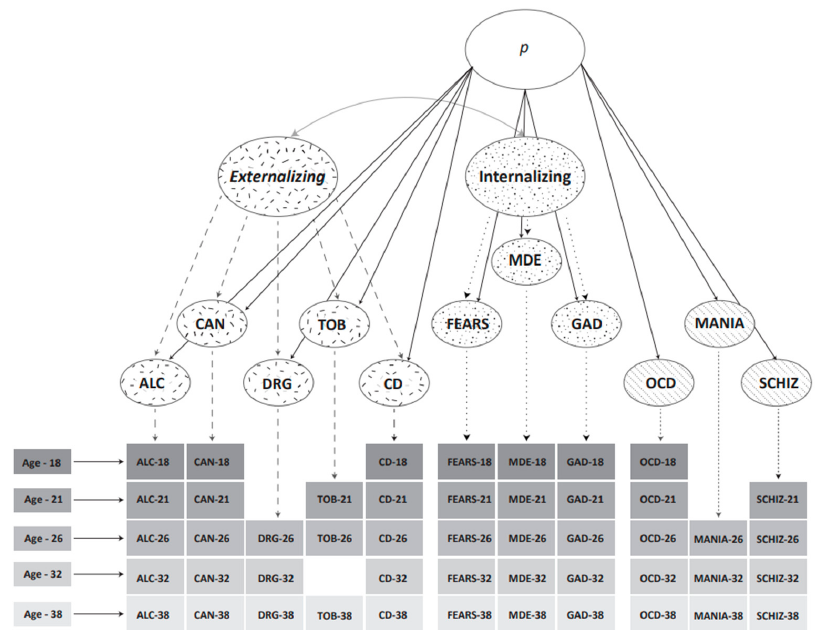
Figure 2. Adapted from Caspi et al [13]. Ovals represent latent symptom factors; boxes represent the symptoms related to each disorder. The 11 disorders included in the model are: alcohol de- each disorder. The 11 disorders included in the model are: alcohol dependence, cannabis dependence, dependence on hard drugs, tobacco dependence, conduct disorder, major depression, generalized anxiety disorder, fears/phobias, obsessive- compulsive disorder, mania, and positive and negative schizophrenia symptoms. Note . ALC = Alcohol. CAN = Cannabis. DRG = Hard drugs. TOB = Tobacco. CD = Conduct disorder. MDE = Major depressive episode. GAD = General Anxiety Disorder. OCD = Obsessive Compulsive Disorder. SCHIZ =